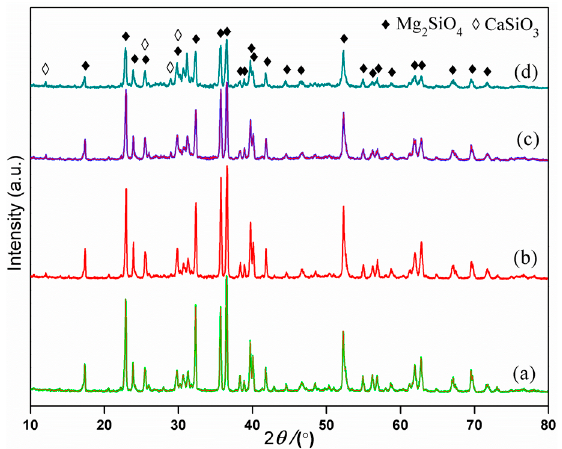
Figure 4. X-ray diffraction patterns of the scaffolds with: ( a ) 0 wt %; ( b ) 10 wt %; ( c ) 20 wt %; and ( d ) 25 wt % CaSiO 3 .